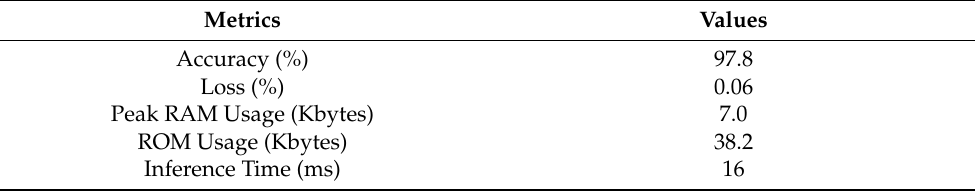
Table 5. Performance characteristics of the Edge Impulse model.